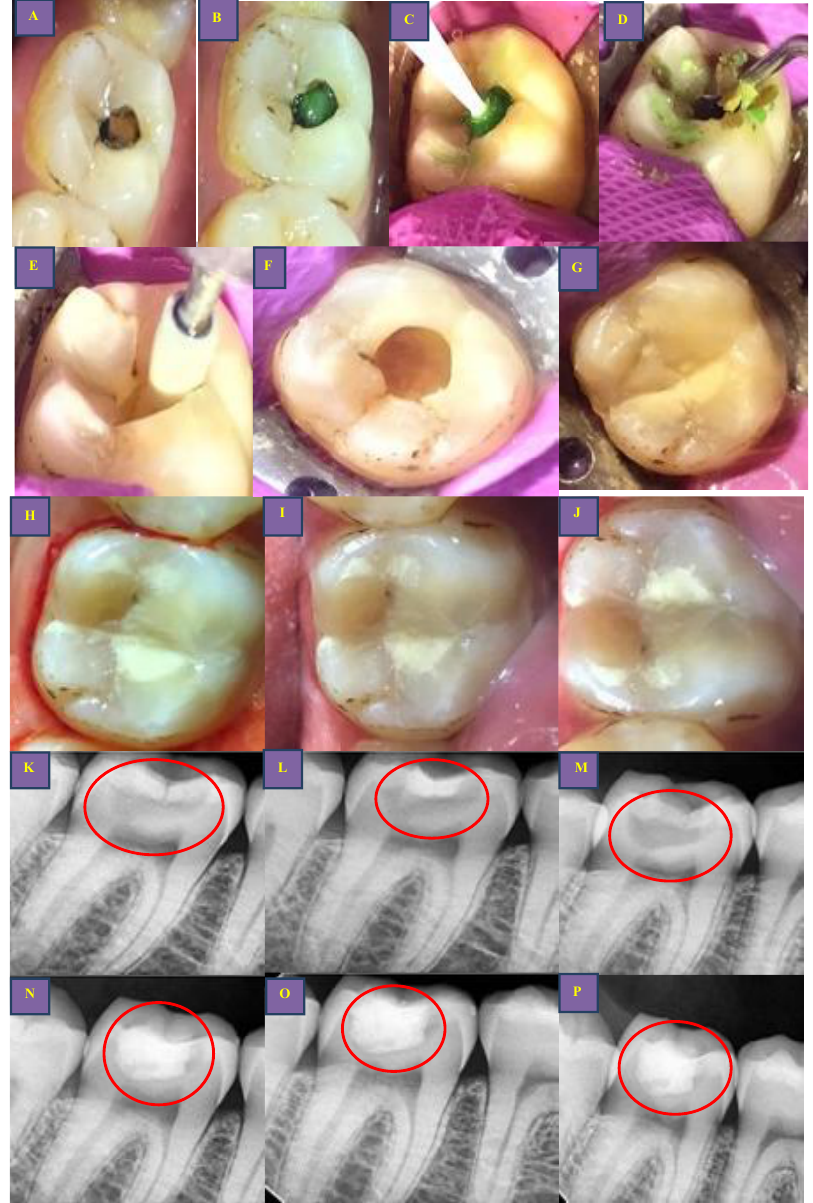
Figure 4. Clinical steps for occlusal caries group (BCD group): ( A , K ): preoperative clinical photo and radiograph (red circle); ( B , C , L ): application clinically and extension of radiopaque BCD on radiograph (red circle); ( D ): caries excavation with spoon excavator and caries debris during excavation; ( E ): Finishing of cavo-surface margins using Arkansas stone; ( F , M ): final prepared cavity and post-caries excavation radiograph (red circle); ( G ): cavity restored with RMGIC material: ( H , N ): post-restoration clinical photo and radiograph (red circle) after 3 months; ( I , O ): post-restoration clinical photo and radiograph (red circle) after 6 months; ( J , P ): post-restoration clinical photo and radiograph (red circle) after 12 months.